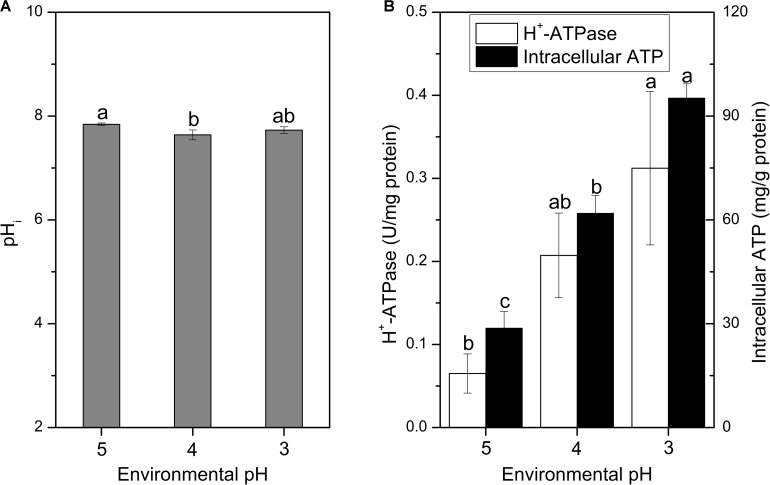
Changes in pHi
(A), H+-ATPase and intracellular ATP concentration (B) of S. albulus M-Z18 in batch fermentations at different environmental pH (pH 5.0, 4.0, and 3.0). Samples were collected at 27 h. Statistical significance is denoted by different letter for the same indicator.